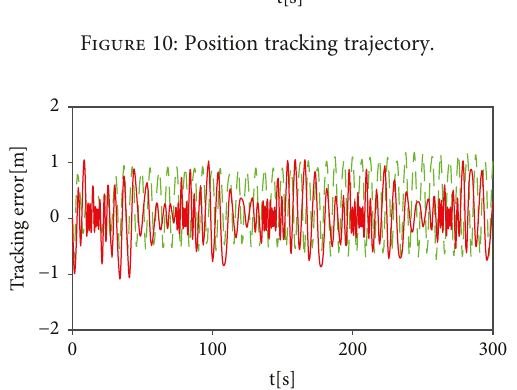
Figure 11: Tracking error curve.